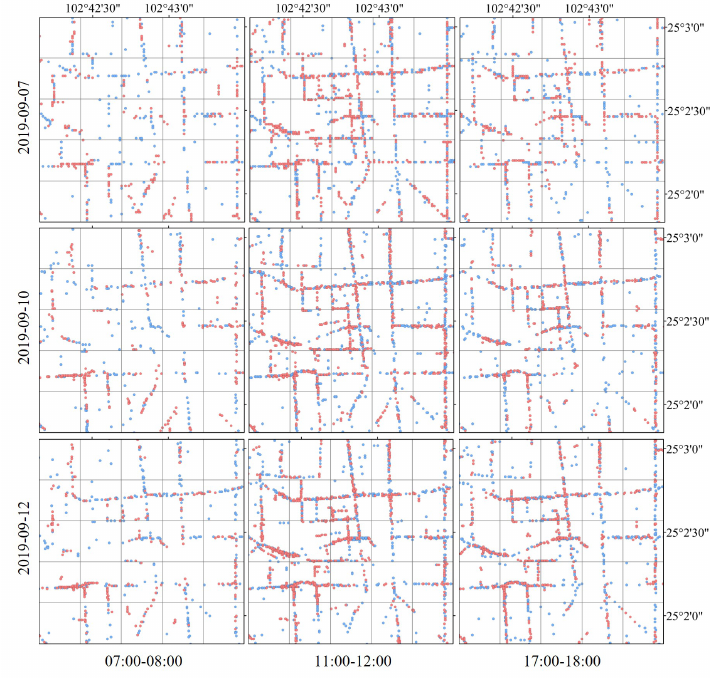
Figure 2. Distribution of pick-up and drop-off points in parts of the area. (Blue dots are pick-up points, and red dots are drop-off